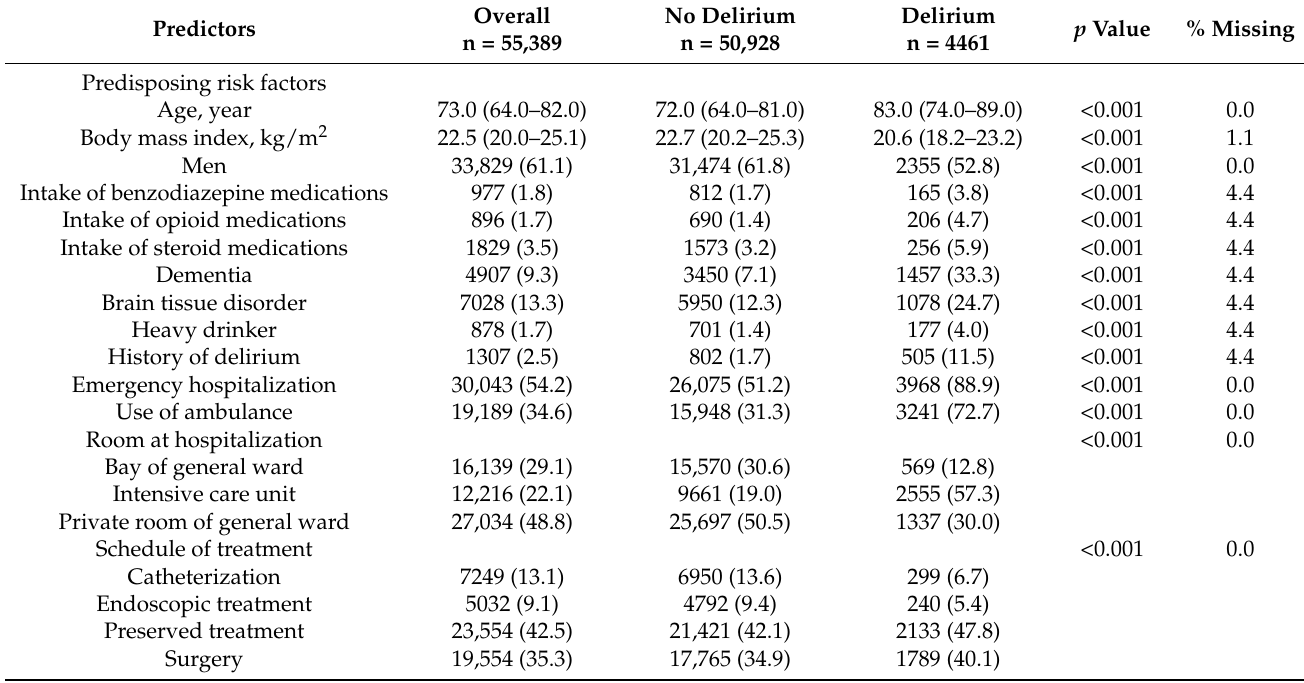
Table 1. Predictor characteristics in analysis population